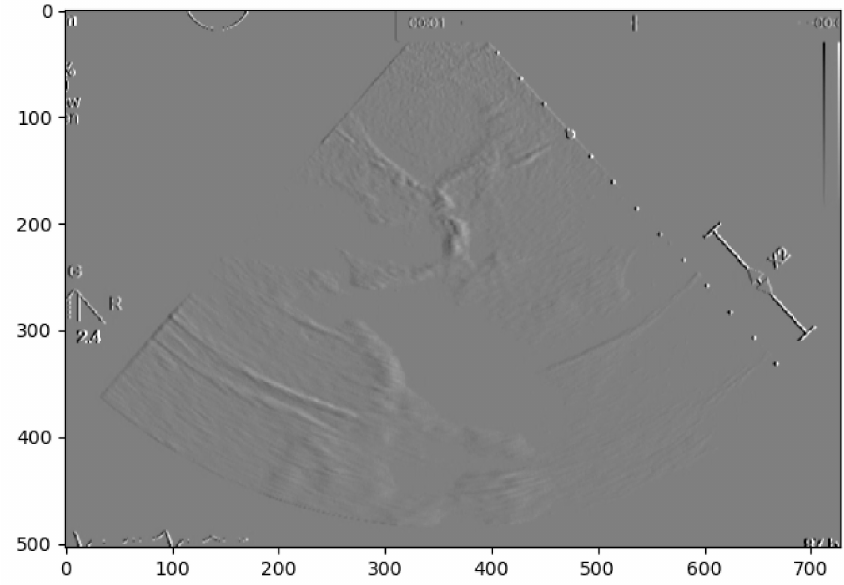
Figure 3. Echocardiography image with edge